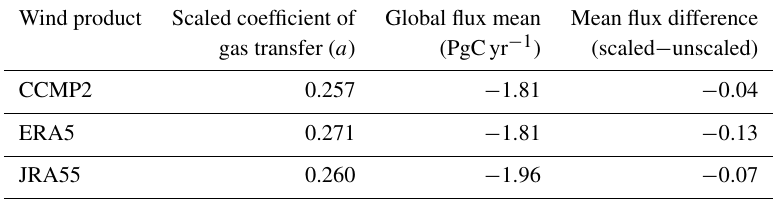
Table 2. CSIR-ML6 product flux values. Column 1 lists the scaled coefficient of gas transfer for each of the three wind reanalysis products. Column 2 includes the global mean flux using each wind product. Column 3 shows the difference in resulting flux when using a scaled coefficient of gas transfer versus a set value of 0.26. All flux values reported are from the area-filled product version. All values are computed over the period 1990–2019.